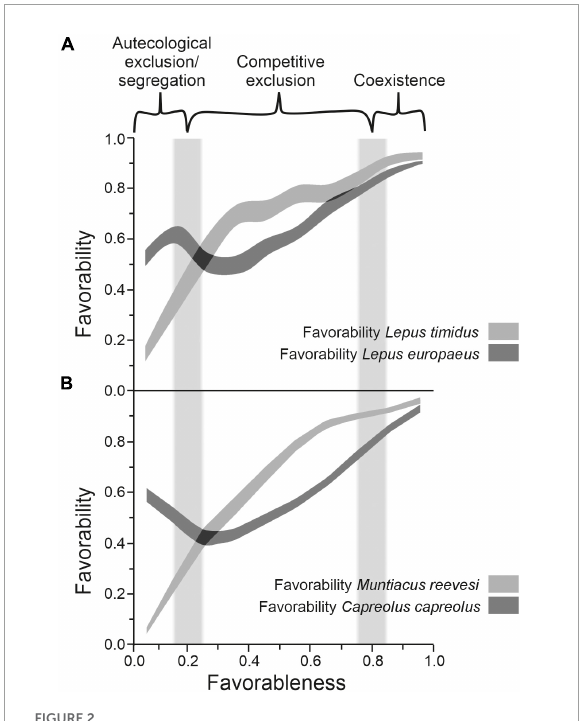
FIGURE2 Examples of biogeographical outcomes of species interaction after representing the mean favorability of individual competing species along their favorableness grandient. Favorableness and favorability are defined as in Figure 1 . (A) Lepus timidus and L. europaeus in Europe (Acevedo et al., 2012). (B) Muntiacus reevesi and Capreolus capreolus in Great Britain (Acevedo et al., 2010). Plots result of joining the 95% confidence intervals of mean favorability values of the locations grouped in 10 bins of equal range along the favorableness gradient. Fuzzy columns as in Figure 1